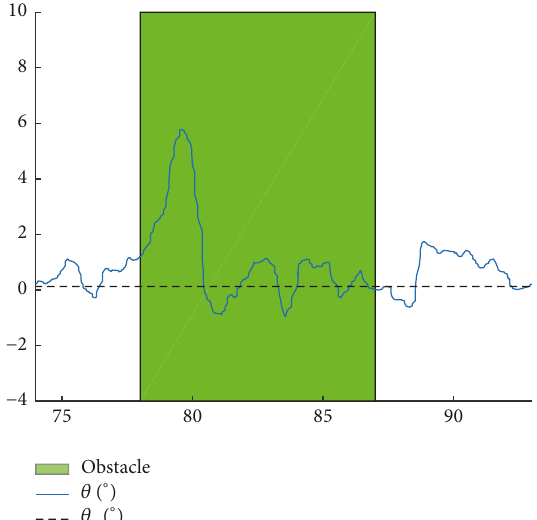
Figure 28: Experiments in the test bench: variations of the quadro- tor pitch angle when placing a ground plane under one of the rotors (green background).